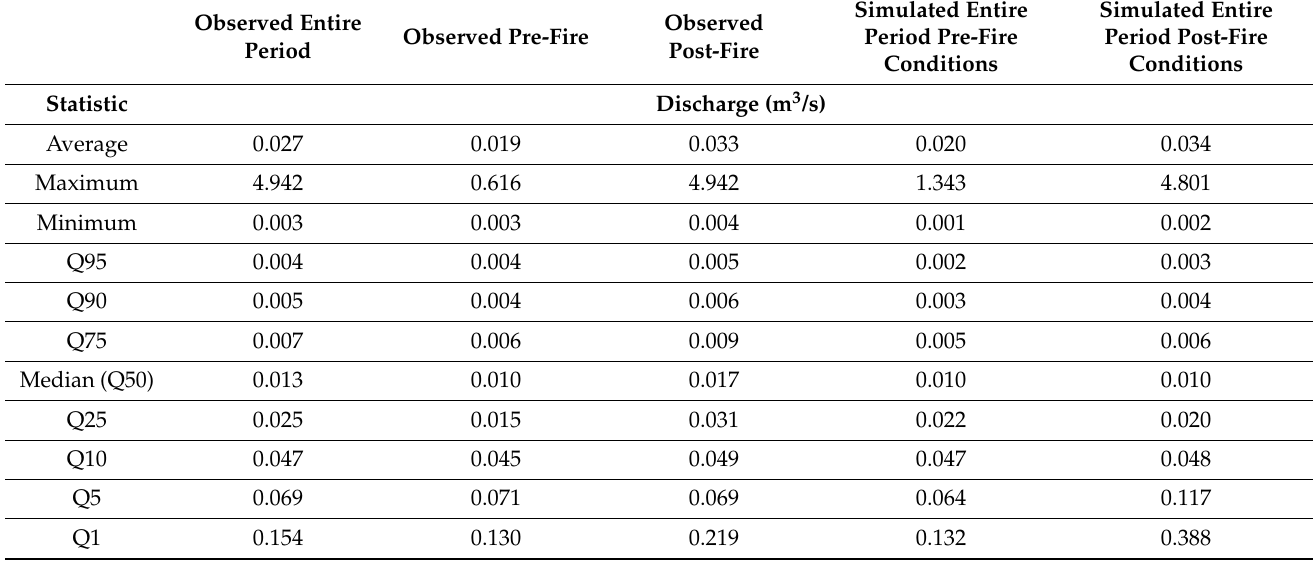
Table 3. Statistics of the observed and the simulated daily discharges. Q1 to Q95 are the percentile flows, which are the flows equaled or exceeded at least at the corresponding percentage of the time.